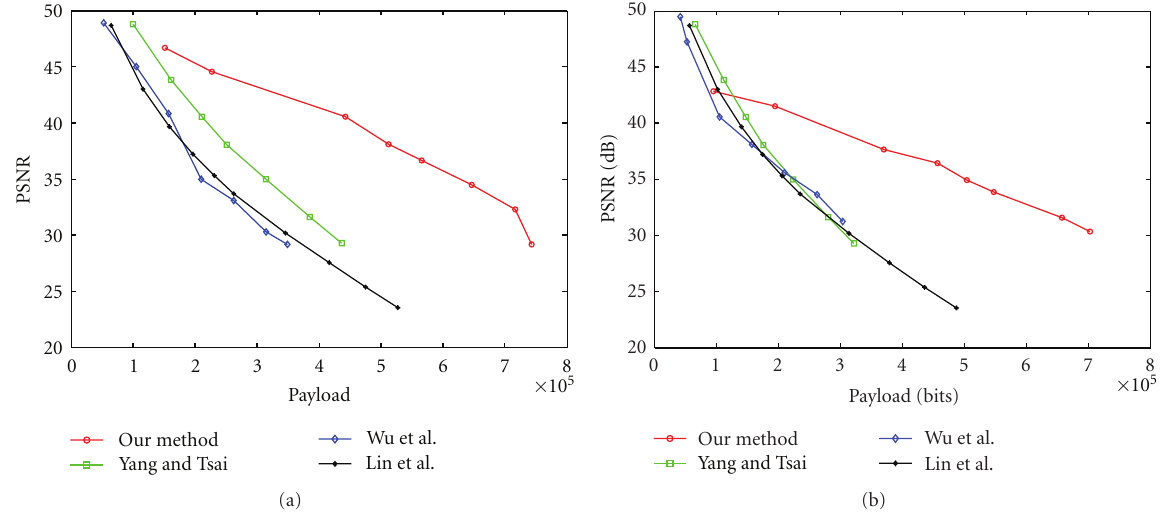
Figure 8: Performance comparison between various methods on two test images. (a) Lena and (b) Boat . Table 3: Comparisons of the related secret image sharing